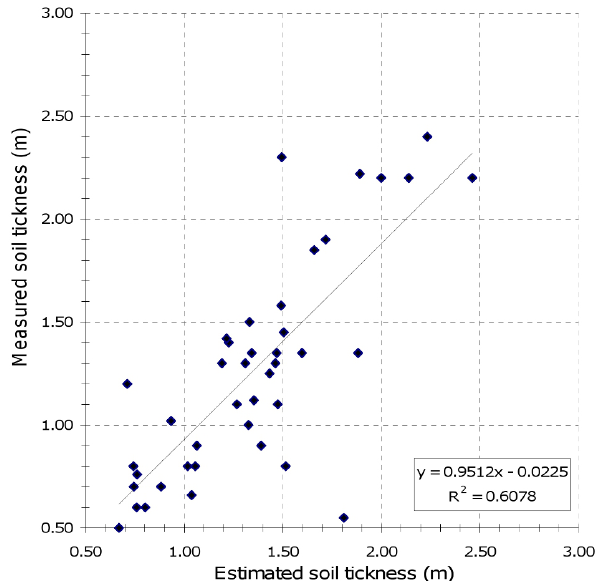
Fig. 4. Measured vs. estimated soil thickness.